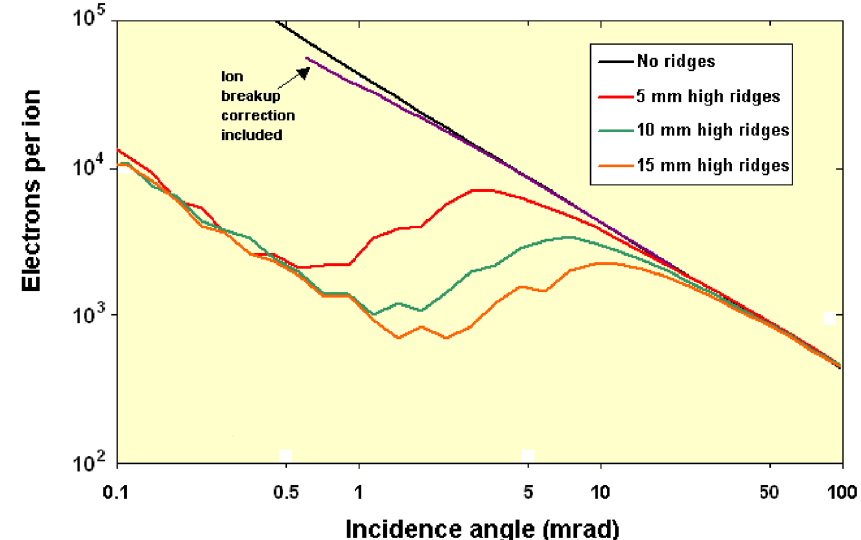
FIG. 11. (Color) Electron yields for 9 : 6 GeV = amu gold ions incident on stainless steel with ridges placed at 2.5 m intervals. Desorption rates will follow similar